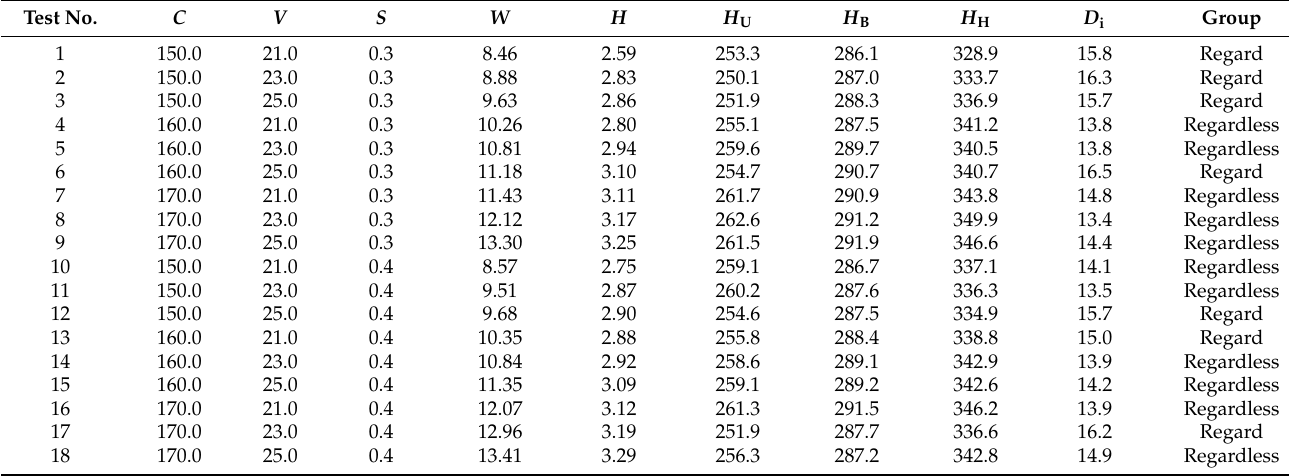
Table 9. Learning data for discriminant of flux cored arc welding